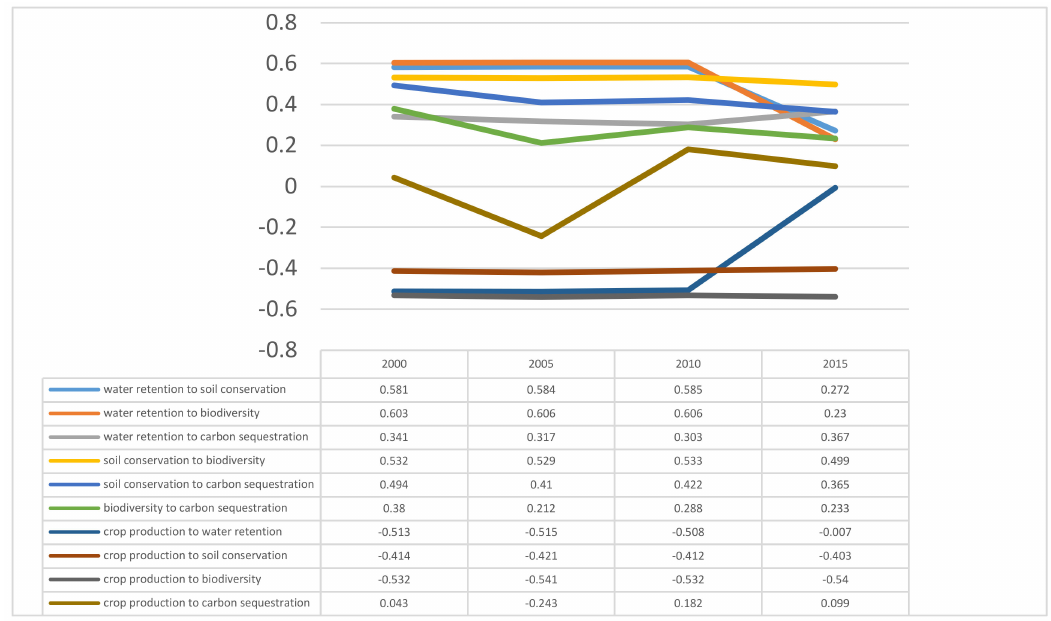
Figure 21. Ecosystem service synergy/trade-off change